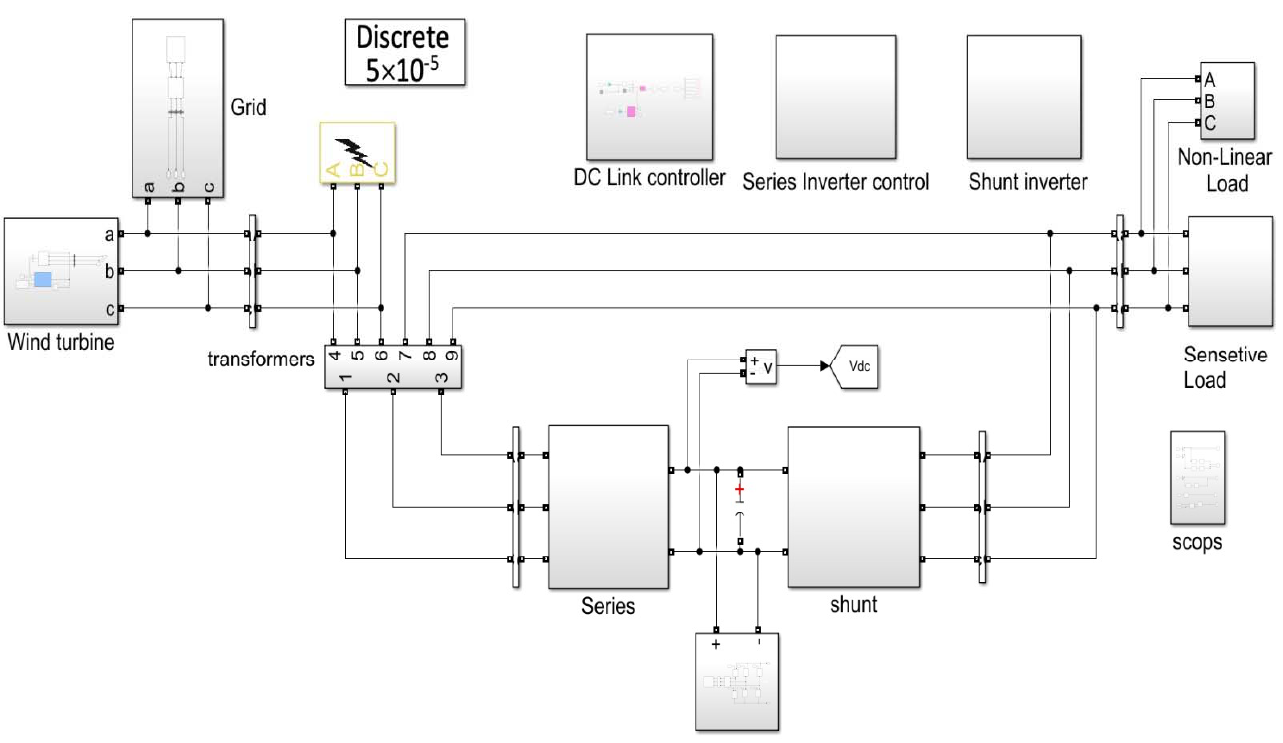
Figure 19. The full simulation for the system (non ‐ linear load on the load side).